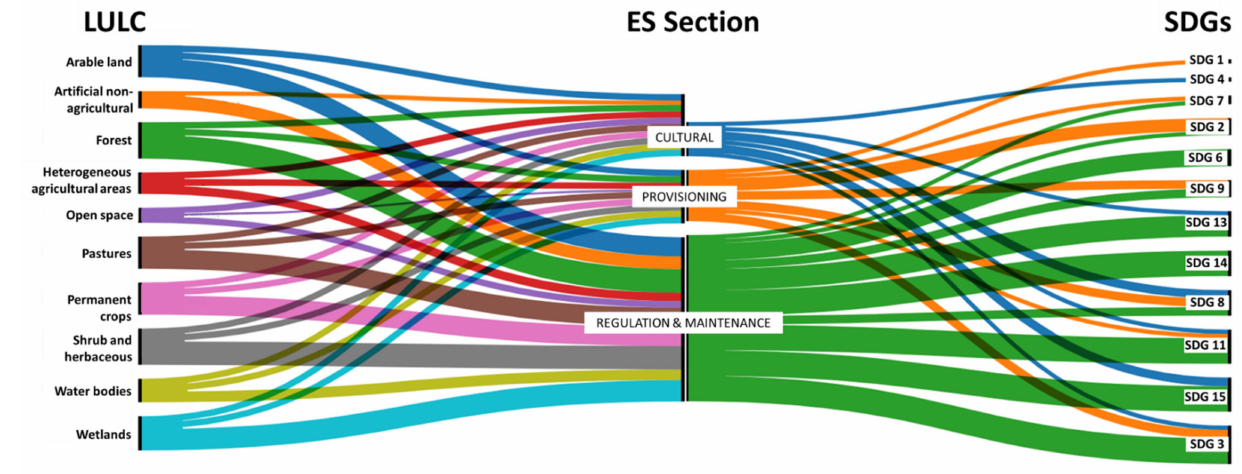
Figure 8. Sankey diagram representing the flow of relations among LULC, ES, and